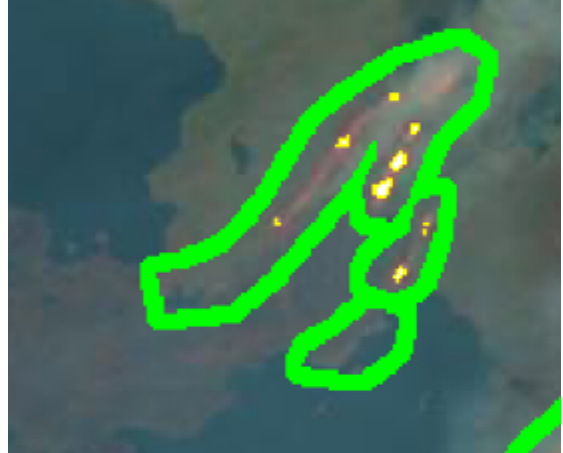
Figure 2. An example of marks. Yellow and white pixels are fire pixels and green pixels are non-fire pixels